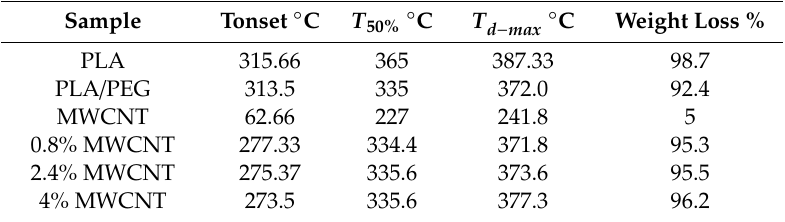
Table 2. Thermal properties and weight loss parameters of the PLA, MWCNTs powder, PLA / PEG blend, and MWCNT / PLA / PEG